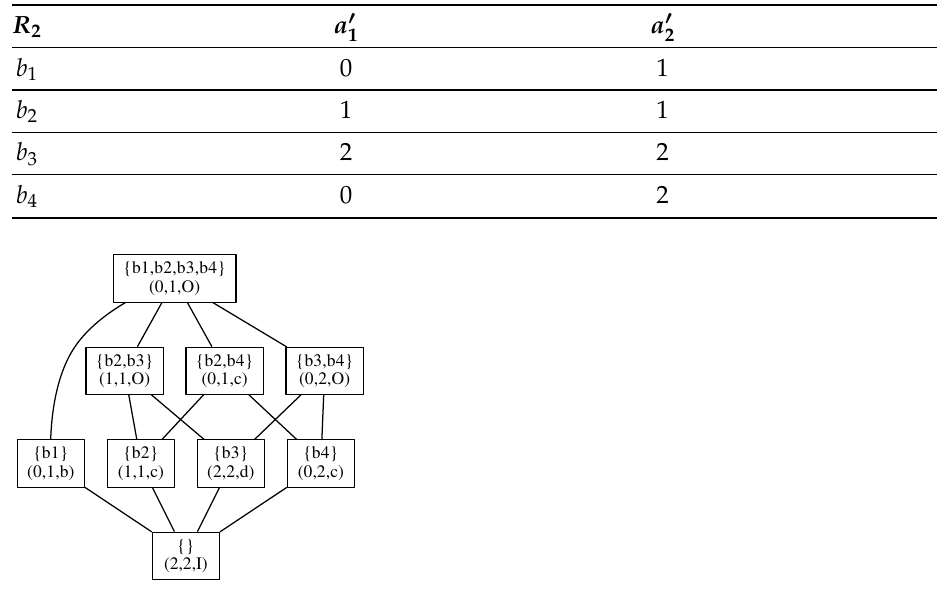
Figure 2. Generalized one-sided concept lattice C ( c 2 ) corresponding to the context c 2